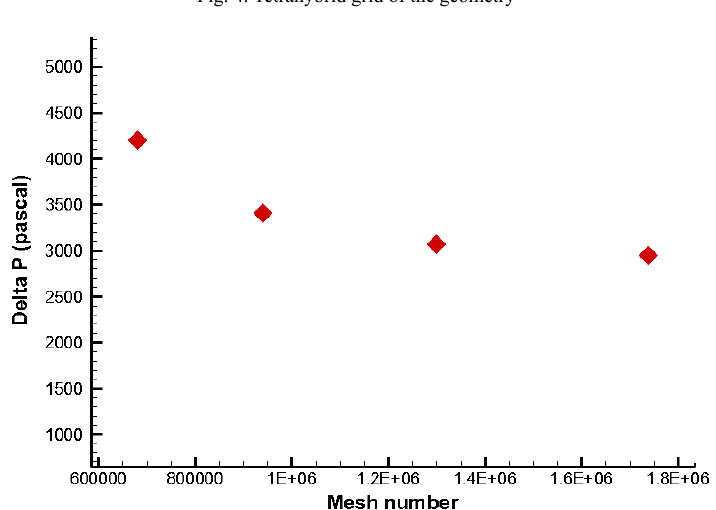
Fig. 5. Grid Fig. 5 Grid independency